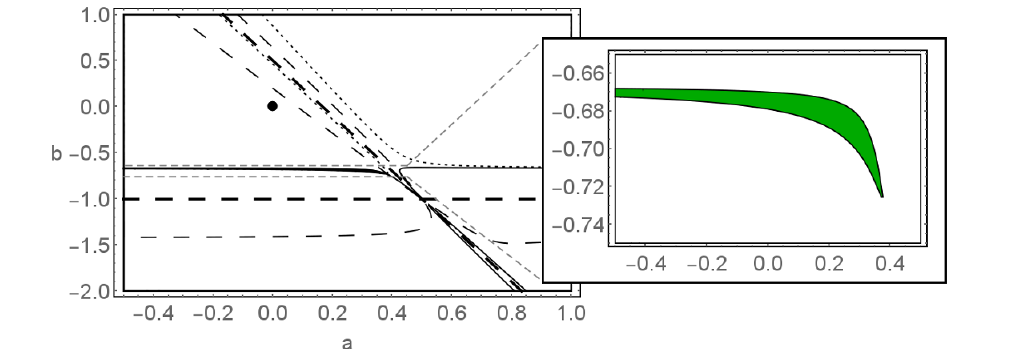
Figure 10 . We show the boundaries of the regions for a UV completion and predictive Higgs mass: f g > 0 above the dashed (thin) line; f y > 0 below the continuous line; (cid:17) (cid:30) j grav > 0 above the dotted line. The thick dashed lines indicates the pole lines 1 + b = 0 and 1 (cid:0) 6 a (cid:0) 2 b = 0. The right-panel zooms in on the overlapping region where the three conditions hold